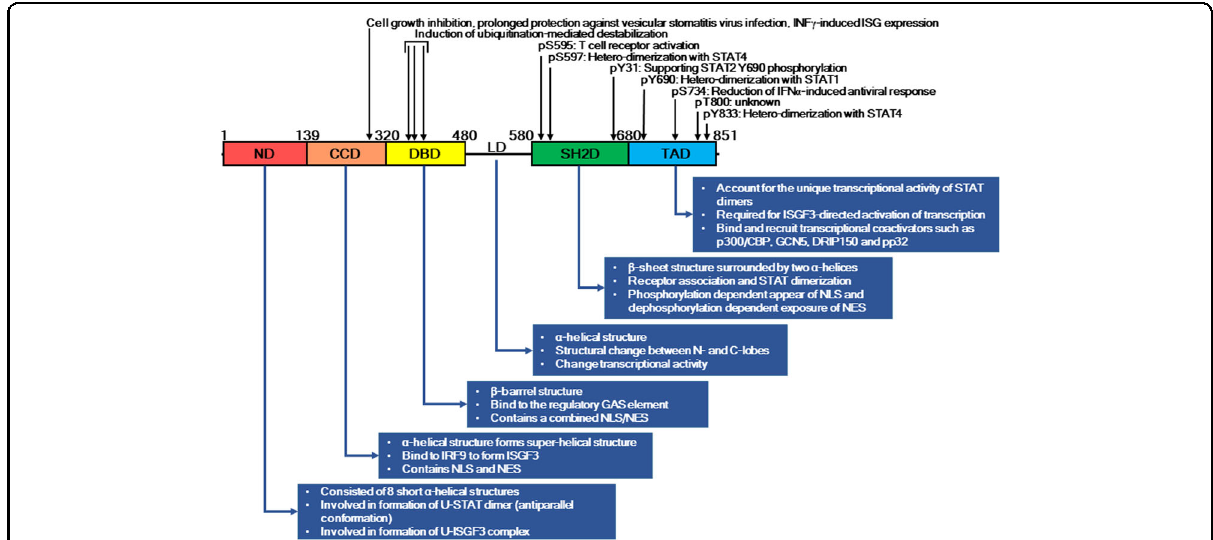
Fig. 3 Characteristics and roles of STAT2 domains. Each STAT2 domain plays a speci fi c role in homo- or heterodimerization and ISG expression. The diverse stimuli from outside or inside cells induce posttranslational modi fi cations such as phosphorylation and ubiquitination to induce structural changes, parallel or anti-parallel oriented homo- or heterodimers, nuclear or cytosolic localization, and DNA